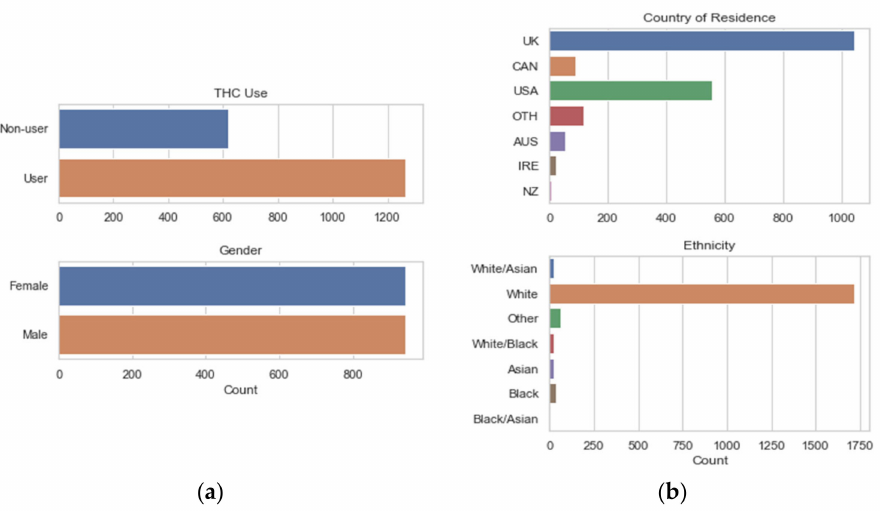
Figure 1. Distribution of the THC Use response variable ( a ) and other nominal categorical variables ( a , b ). UK: United Kingdom, CAN: Canada, USA: United States, OTH: Other, AUS: Australia, IRE: Ireland, and NZ: New